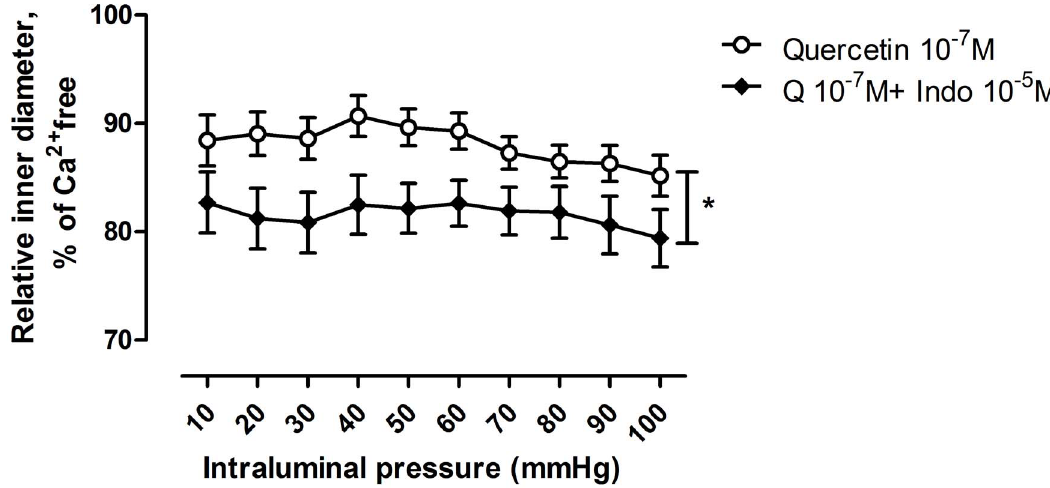
Figure 4. Effect of indomethacin on inner diameter of quercetin-treated coronary arteriole segments. Note contraction with indomethacin (p , 0.05 with ANOVA), in contrast the expected vasodilation, indicating the presence of vasodilatory prostanoids with the polyphenol. Indomethacin concentration was 10 2 5 moles/lit, represented by full circles, quercetin was in 10 2 7 moles/lit concentration, represented by empty circles.